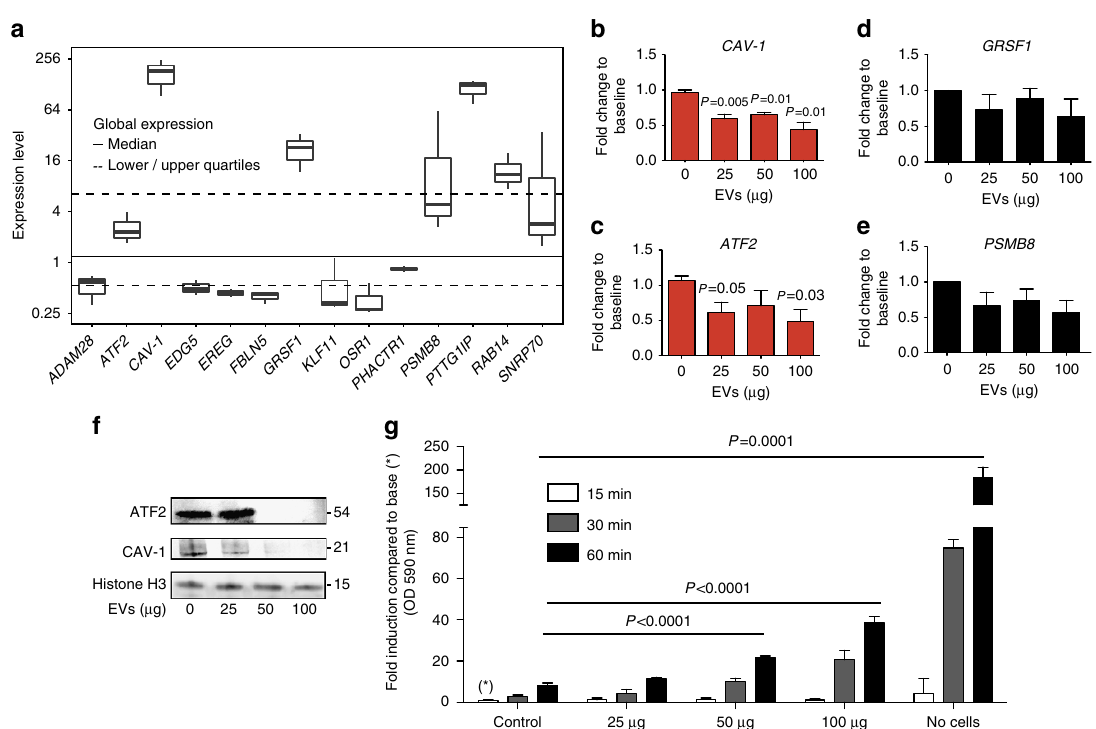
Figure 7 | Downregulation of miR-451a target genes in endothelial cells upon EV uptake. ( a ) Enodogenous expression of miR-451a targets in endothelial cells. Shown is a boxplot for gene expression distribution of putative and known miR-451a targets in untreated BMEC cells 41 , that is, only the control samples from GEO platform GPL2986 (three in total) are included in the analysis. Most variable probe sets were used to represent gene expression when mapping from probe sets to genes isn’t unique. Note the y-axis is log2 scaled. ( b – e ) Expression of miR-451a targets upon EV incubation. Potential miR-451a target transcripts were quantified by qRT-PCR. Two target genes, ( b ) CAV-1 and ( c ) ATF2 show significant downregulation, while GRSF1 ( d ) and PSMB8 ( e ) are not affected significantly in its transcript level. Results are normalized by the 2 -Ct method using EF-1 , and with 18S rRNA as a reference and expressed as mean ( ± s.e.m.) fold induction over untreated control ( n ¼ 3 experiments), P versus control (Student’s t -test). ( f ) Western blot analysis of ATF2 and CAV-1 demonstrates depletion of protein for both markers below detection levels upon incubation with 50 and 100 m g of EVs. ( g ) Effect of EV uptake on endothelial barrier. Endothelial cells were incubated with an EV titration and rhodamine-labelled dextran to measure permeability across a trans-well membrane over time. Permeability across the endothelial layer is significantly increased after 2h of incubation with 50 and 100 m g of EVs. Data represent mean ( ± s.e.m.) from 3 experiments, P versus control (Student’s t